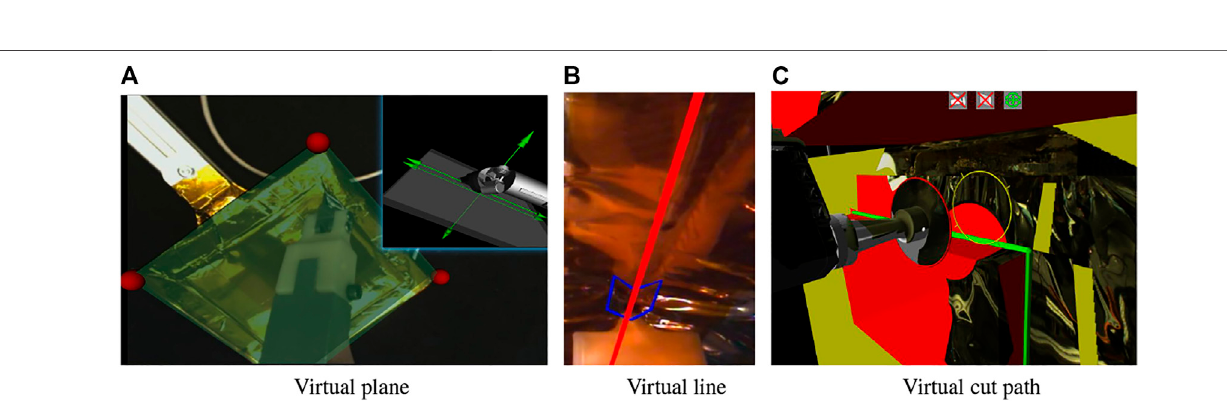
Frontiers in Robotics and AI |